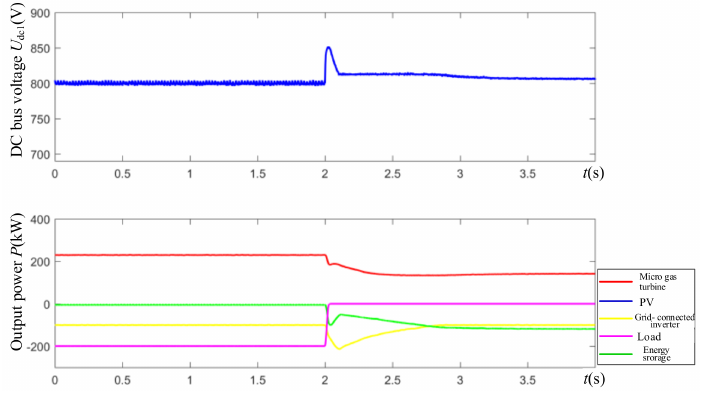
Figure 13. System response when load is